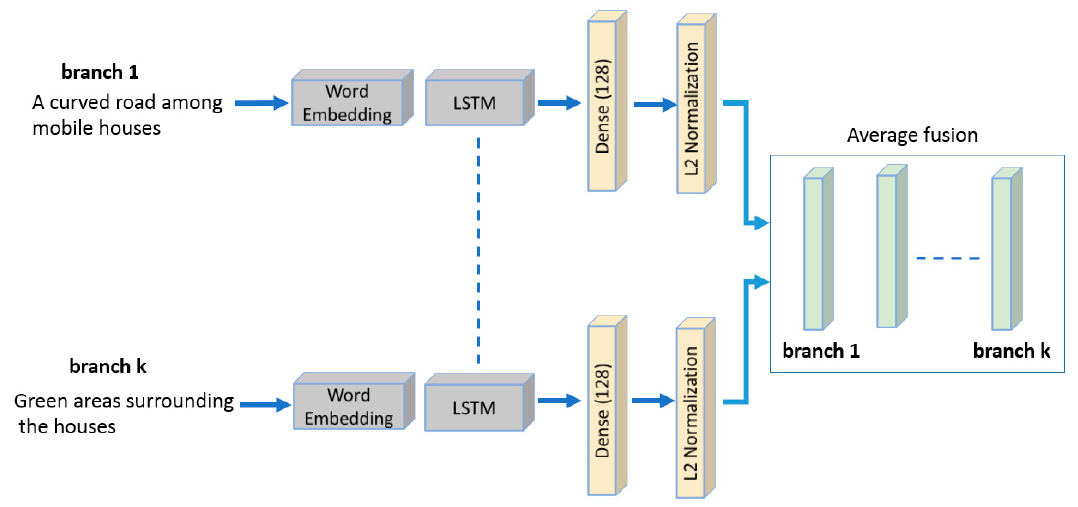
Figure 3. Text embedding branch: The five sentences describing the content of an image are aggregated using an average fusion layer. LSTM is Long-Short Term Memory.